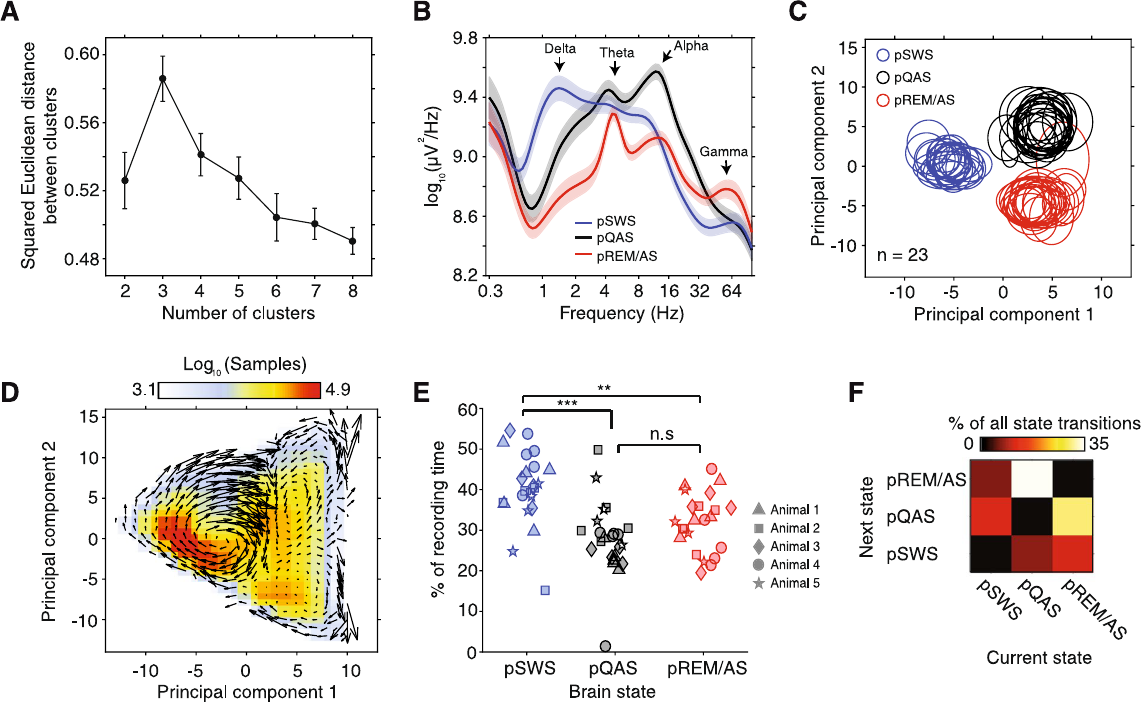
Figure 3. Objective classification of brain state by k-means clustering of data in state-space. ( A ) Data were clustered using a k-means clustering algorithm with the initial assumption of between 2 to 8 data clusters. Squared Euclidean distance between resultant clusters was maximal assuming 3 clusters, indicating that state/ space data is optimally classified into 3 brain state clusters (error bars ± SEM). ( B ) The population average power spectrum computed across clustered brain states. Based on spectral characteristics of each state, clustered brain states were putatively labeled either presumed SWS (blue trace, slow wave sleep), quiet awake (black trace, pQAS), or rapid-eye-movement/active-state (red trace, pREM/AS). ( C ) The distribution of brain state data clusters across the first two principal components for all recording sessions and animals (n = 23). The mean of each cluster in state space is represented by the center of each ellipse, while standard deviation is represented by eccentricity along each axis. Note that brain states consistently localize in the same regions of state space across recordings and animals. ( D ) The number of samples binned across the first two components of state space provides a heat map of where animals spent the most time in state/space. Velocity vectors were overlaid to show the mean trajectories animals traversed through state space. ( E ) The percentage of time spent in each clustered sleep/wake state for each recording session. ** p < 0.01, *** p < 0.001, kruskal-wallis test, Bonferroni corrected p-values. ( F ) The population average rate of transitions between brain states. Note that the most frequency state transitions occurred between pREM/AS and pQAS, which are maximally separated fluctuations along the second principal component Clustering of brain states in PCA-derived state-space. We computed the optimal number of clusters across brain state space by clustering data with a k-means clustering algorithm assuming between 2 to 8 clusters (Fig. 3A). The optimal number of state-space clusters was determined by computing the squared Euclidean dis- tance between all resultant data clusters for each assumed number of clusters. Optimal separation of state-space clusters occurred with the initial assumption of 3 data clusters (Fig. 3A). Therefore, we clustered all state-space data into 3 clusters. To relate each state space cluster to sleep/wake states that have been scored using polisom- nography, we compared LFP power spectra during each state to data from Jha et al . (2006) 17 . Based on this com- parison, we classified resultant states as presumed slow-wave-sleep (pSWS), presumed quiet-awake state (pQAS), and presumed rapid-eye-movement-sleep/active-state (pREM/AS). By plotting the distribution of clustered data across the first two components of PCA-derived state-space, one can observe that classification of brain states is consistent across different recording sessions and animals (Fig. 3C). To show how animals traversed state space over time, we computed the first derivative across each of the first two principal components, and combined this information to construct velocity vectors in state-space (Fig. 3D). This approach revealed characteristic trajectories between all brain states. For example, when observed across the first two principal components, animals first entered the pSWS cluster from the lower right quadrant, before cir- culating in a clockwise fashion through the pSWS cluster to finally exit from the upper right quadrant (Fig. 3D). Similar characteristic trajectories were observable for the other brain states. Collectively, state-space trajectories support the hypothesis that resting/awake brain states are best represented by a continuum of constantly fluctuat- ing neuronal variables, with states overlapping and flowing into one another 18 .